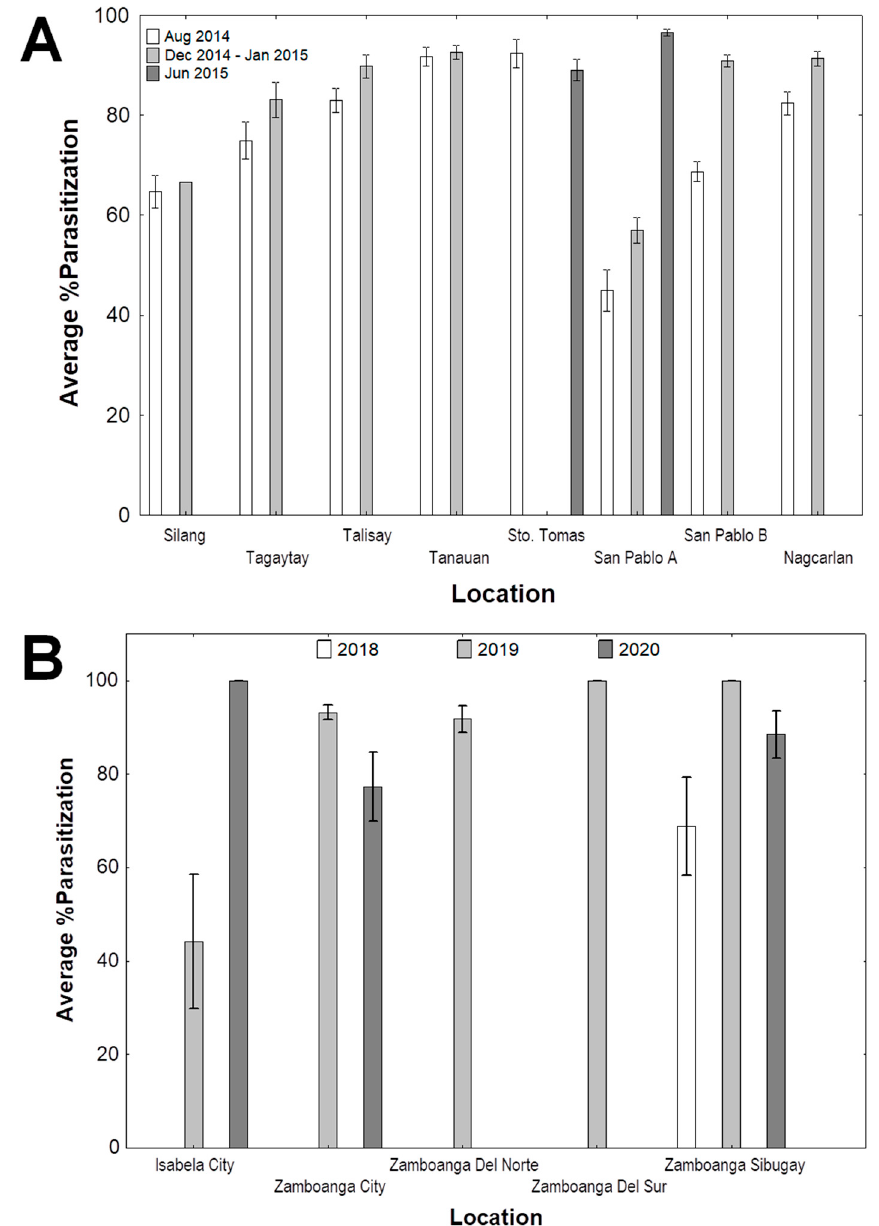
Figure 4. Levels of parasitization (mean ± SEM) of Aspidiotus rigidus by Comperiella calauanica in the field across survey points in Southern Tagalog ( A ) and in provinces in the Zamboanga Peninsula ( B ) for three sampling periods.